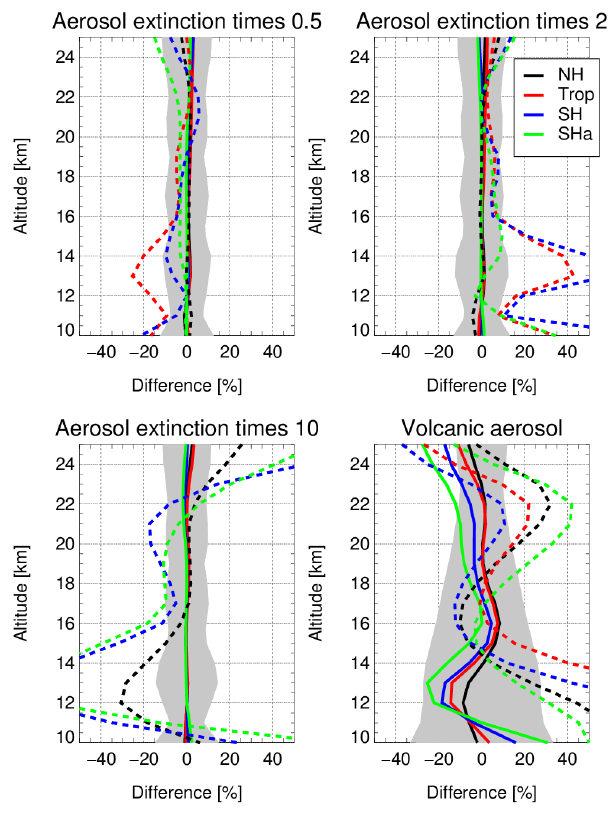
Figure 5. End-to-end test for different perturbations of the aerosol profile. In both upper panels and in the lower left panel the dashed lines show cases where the whole aerosol extinction profile (0– 100km) is perturbed by multiplying by a factor (given in the title of each panel); solid lines show cases where the perturbation is lim- ited to 0–30km. The lower right panel shows cases where the back- ground aerosol profile is exchanged with cases for aged moderate (solid lines) and fresh high (dashed lines) volcanic aerosol accord- ing to the LOWTRAN model. The four colours show different ob- servation geometries. The smoothing with the AVK is done for all cases. The grey shading shows the maximum of retrieval